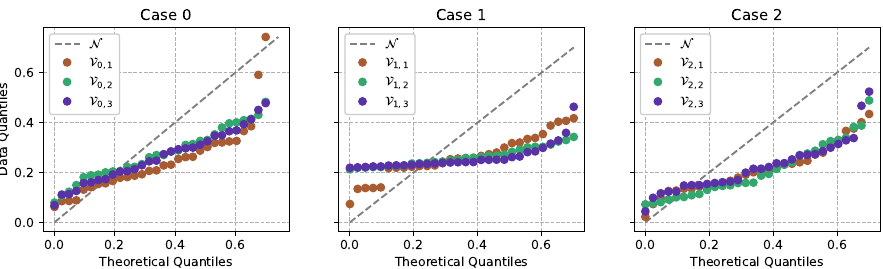
Figure 9. Quantile–quantile (Q–Q) plots of the velocity distribution (in magnitude) for each case studied (0: no filter; 1: 1 (in) filter; 2: 2 (in) filter), organized per room in blocks of 3. The symbol N denotes the normal distribution; each N denotes the normal distribution and V c , r denotes the velocity distribution for the c -th case of the r -th room. It can be verified that all cases move away normality but expound similar behaviors.